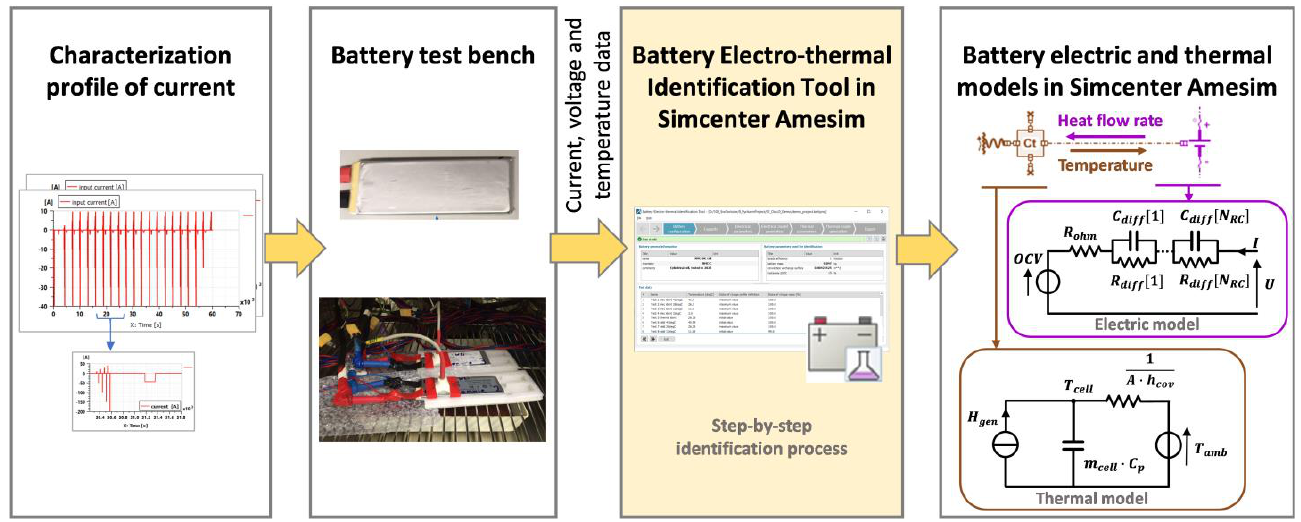
Figure 2. One-dimensional cell model parameterization workflow.